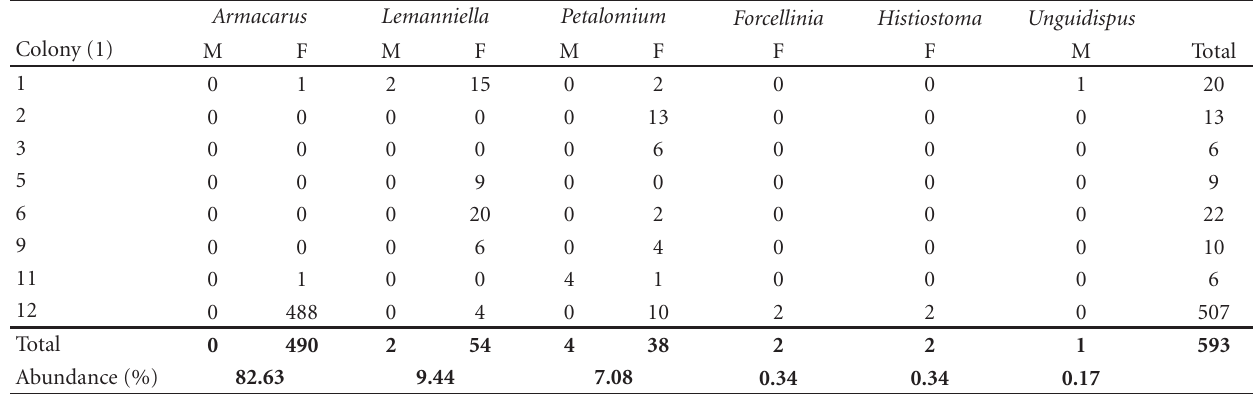
Table 4: Number of representative specimens of the six mite genera found on male (M) and female (F) alates on Messor pergandei .